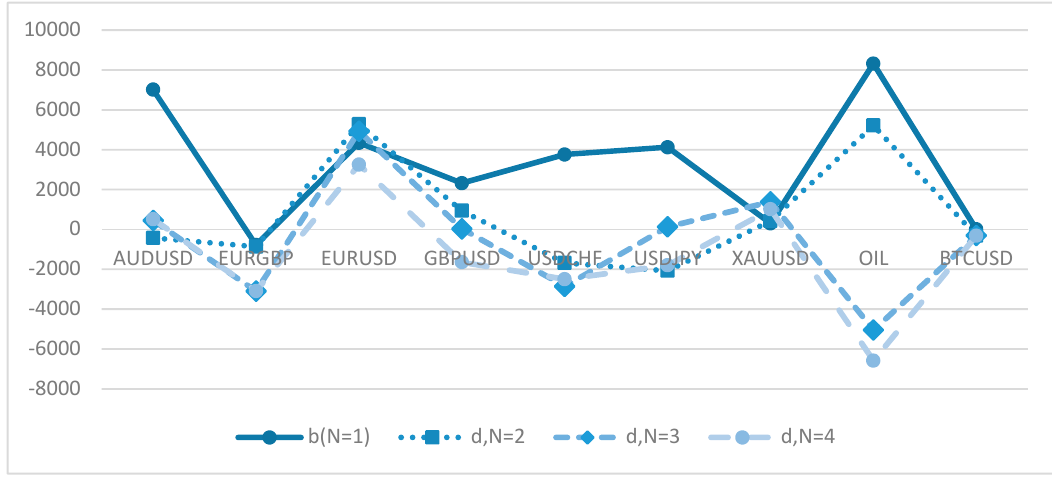
Figure 8. Net Profits of experiment (d) for various values of N.